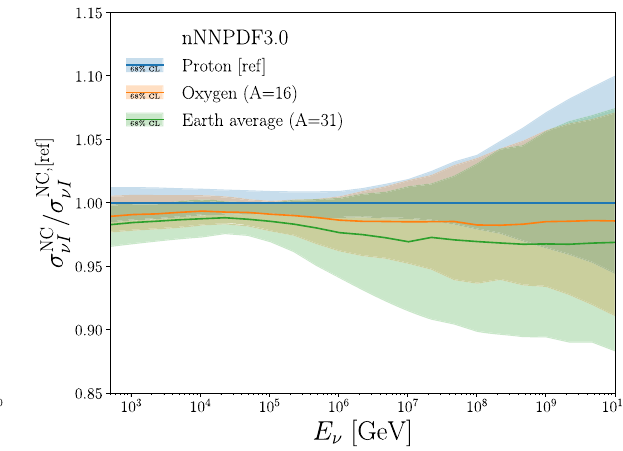
Fig. 29 ComparisonoftheinclusiveCC(left)andNC(right)neutrino- nucleon cross-section as a function of incident neutrino energy. Predic- tions are shown for isoscalar nuclear target with A = 1 , 16 , 31, where